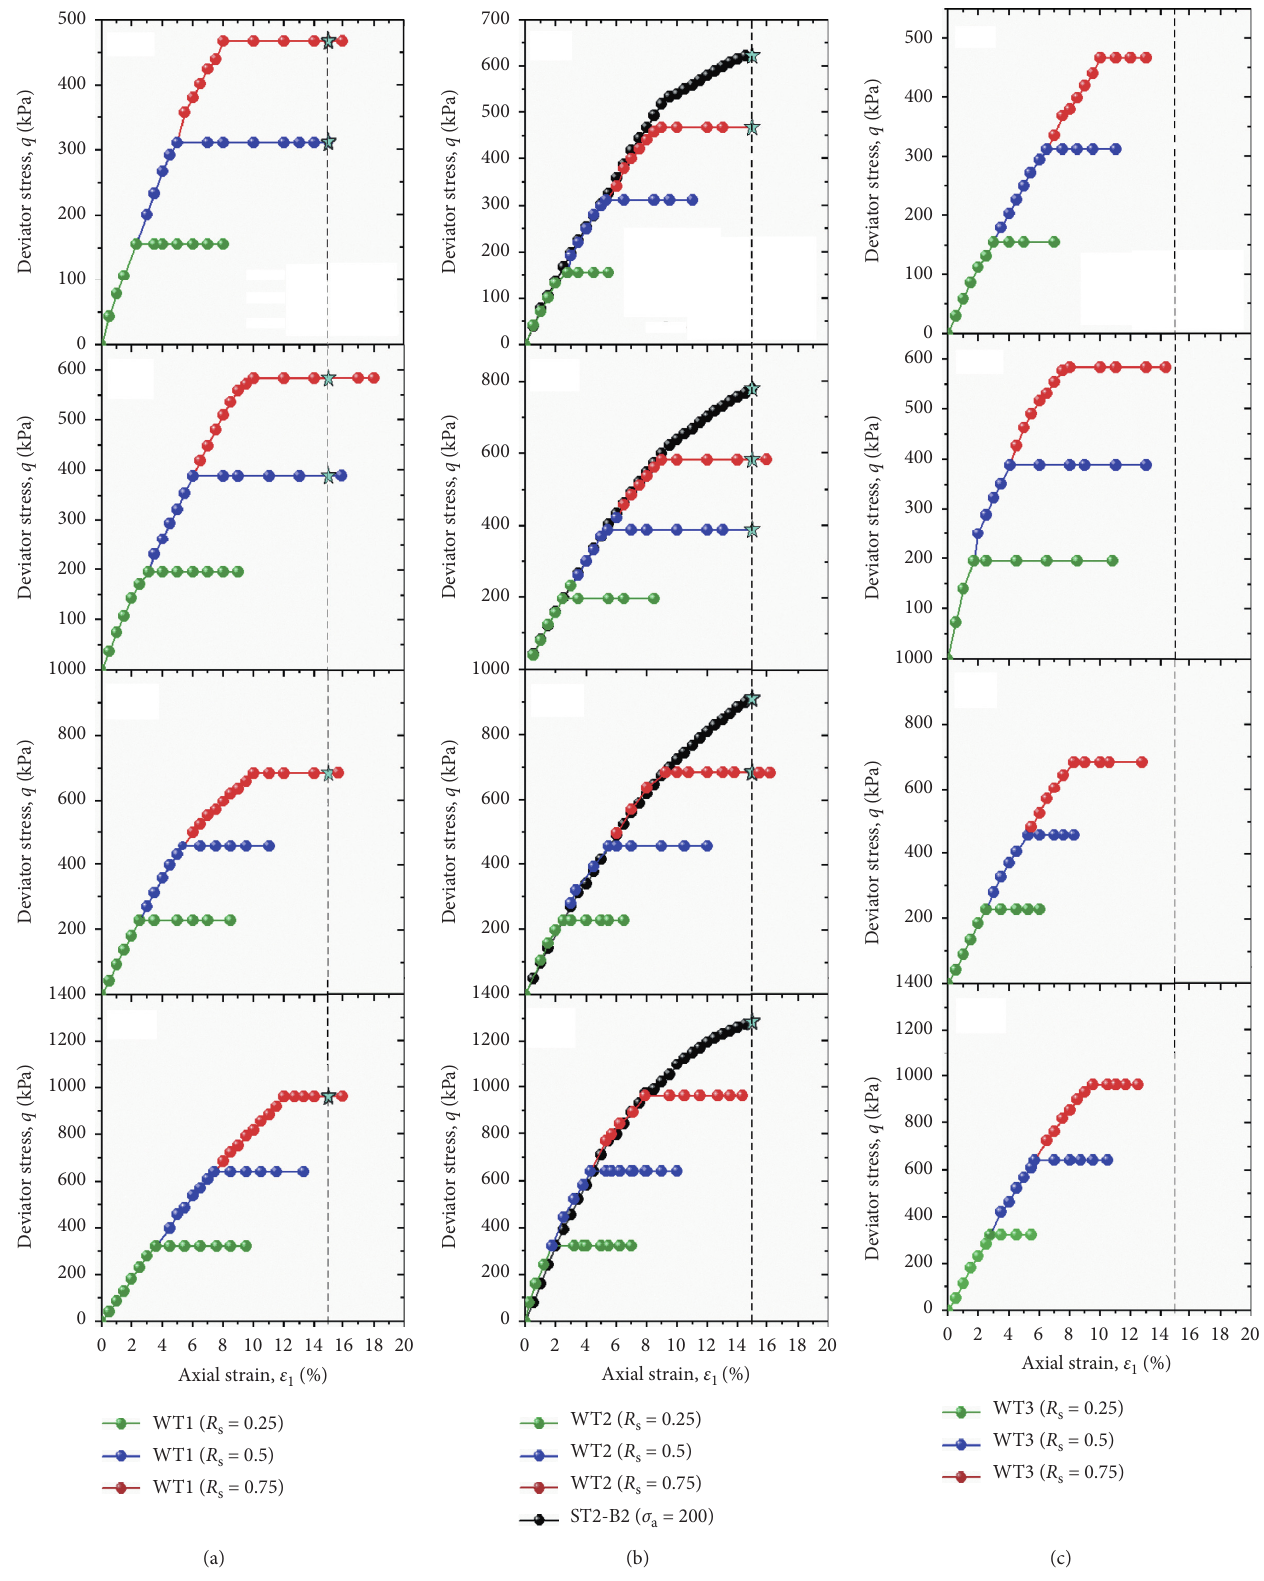
Figure 12: Deviator stress-axial strain curves from WT. The content of filling materials: (a) 10%; (b) 15%; (c) 20%. The net confining pressures: 50 kPa, 100kPa, 200kPa, and